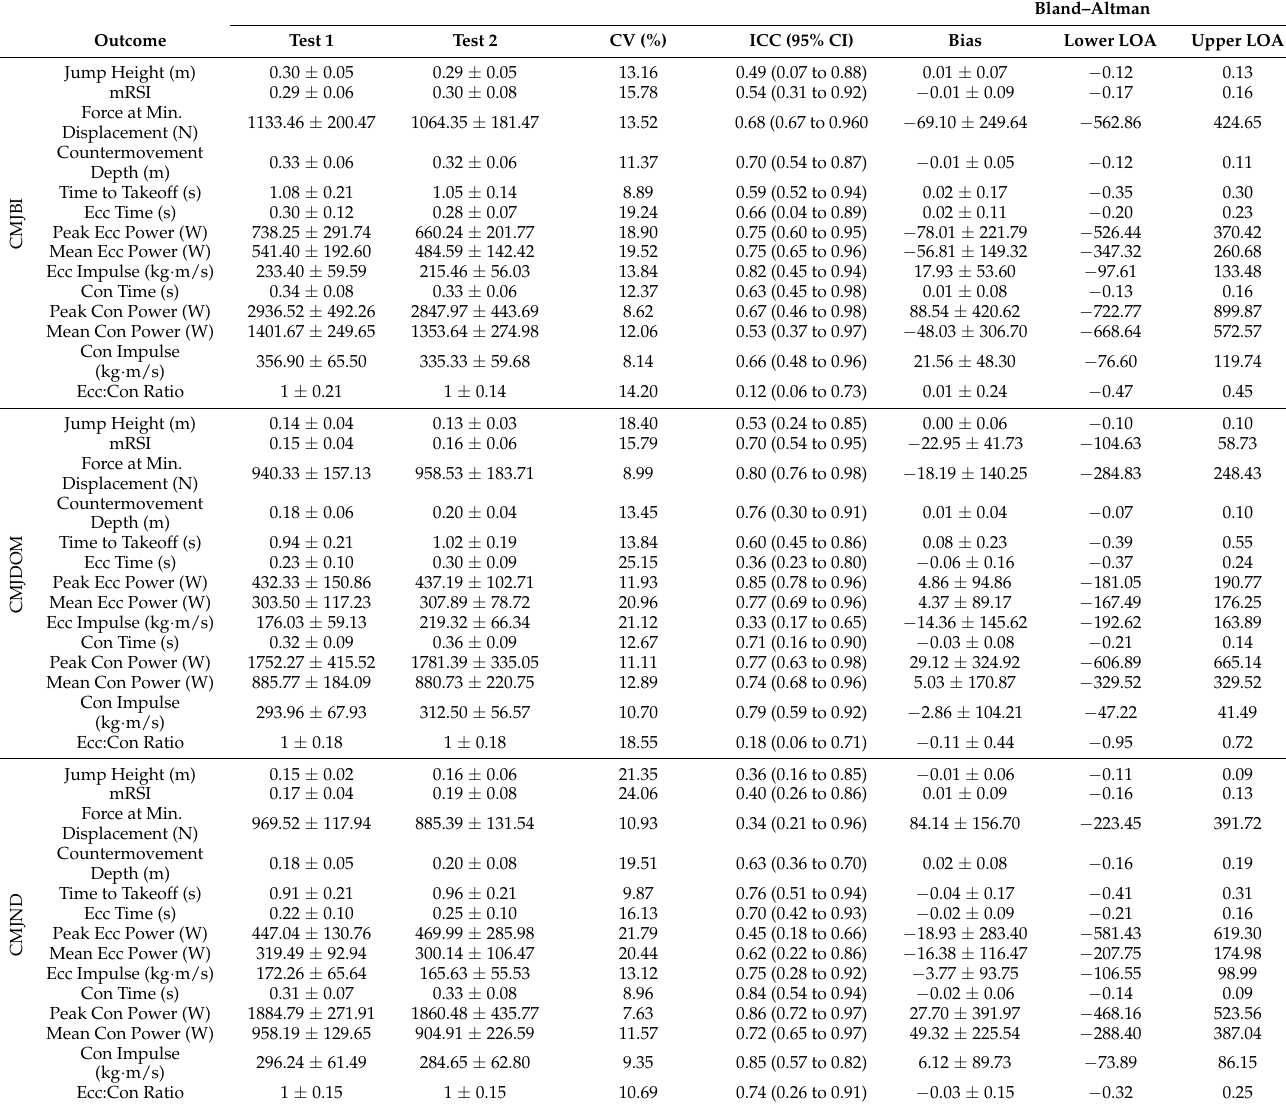
Table 1. Test Re-Test reliability of CMJ BI , CMJ DOM and CMJ ND.